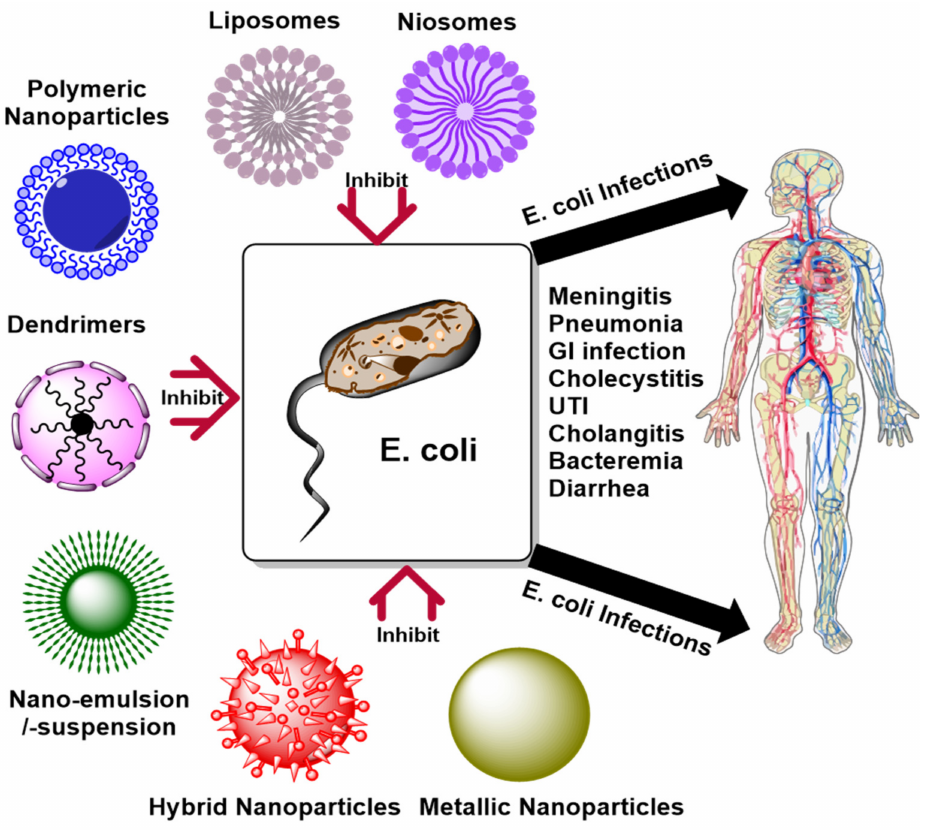
Figure 10. Different types of nanomaterials used to inhibit E. coli